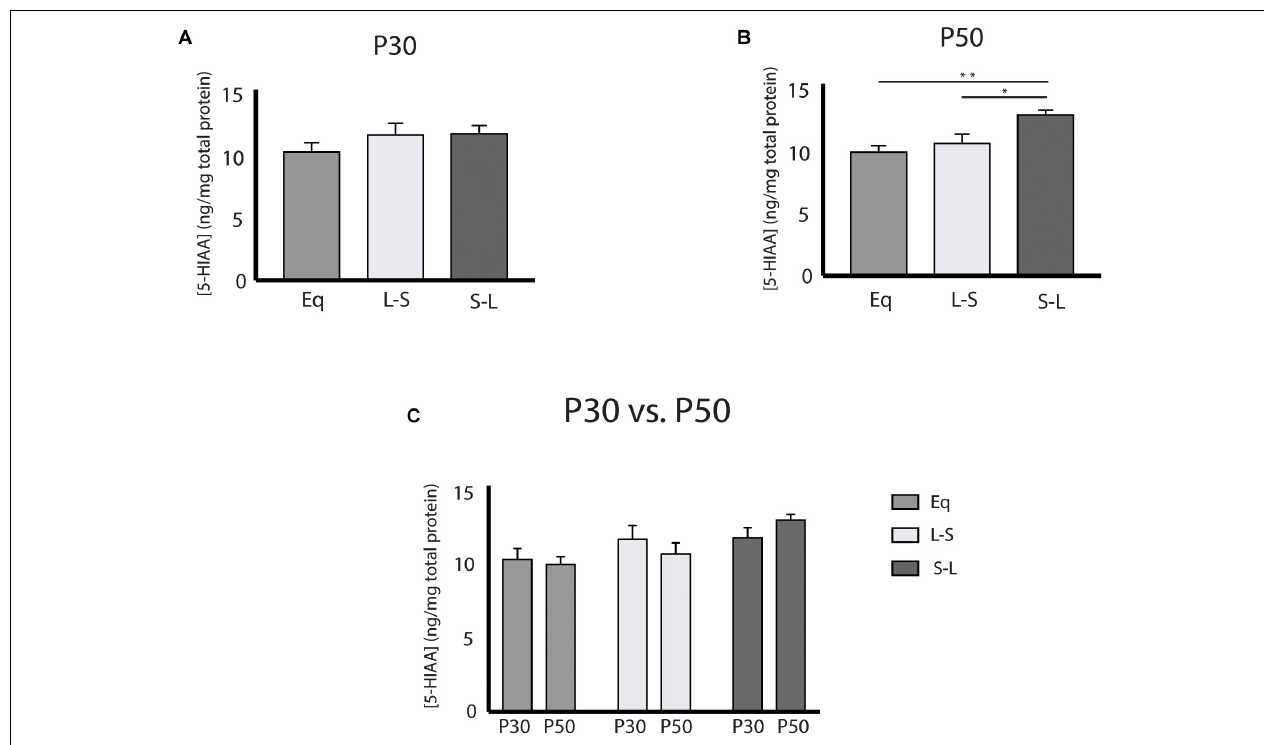
FIGURE 3 | Postnatal Long photoperiod exposures result in lasting changes in 5-hydroxyindoleacetic Acid (5-HIAA) concentration. (A) Analysis of 5-HIAA content across photoperiods at P30, (B) at P50 and (C) within photoperiods during the P30 and P50 time points. The significance levels are as follows: ( ∗ p < 0.05, ∗∗ p < 0.01) using Holm-Sidak’s multiple comparison